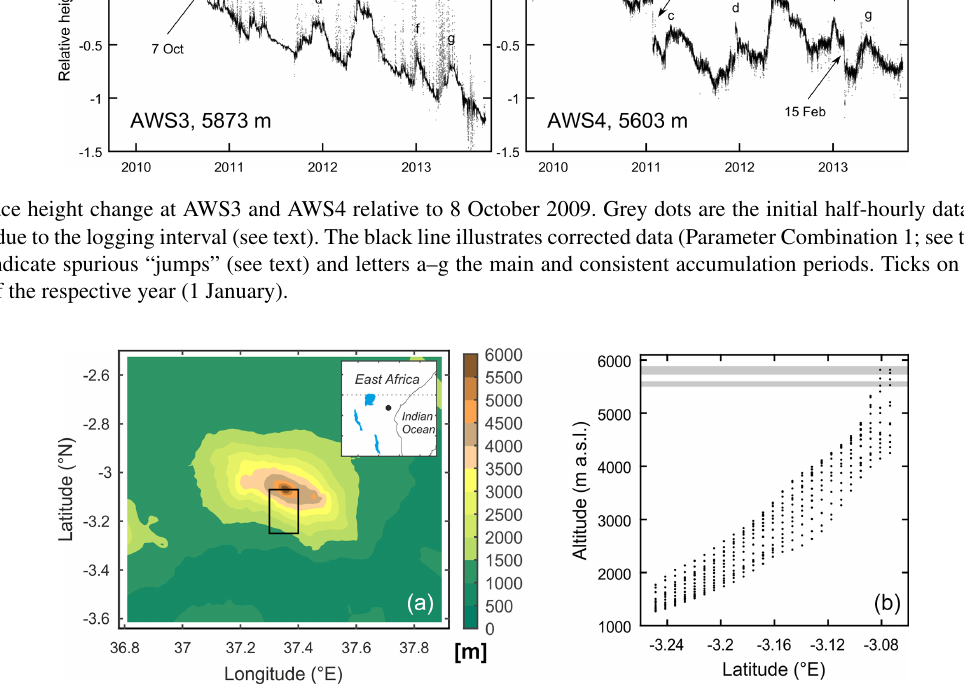
Figure 3. (a) Topography of the innermost domain in the atmospheric modeling study of Collier et al. (2018). The black box delineates the “southern mountain slope” defined in the present study. Inset in the upper-right corner illustrates the full area covered by the model’s (outermost) computational domain and the location of Kilimanjaro (dot). (b) Meridional profile of altitude on the southern slope indicated by the single grid points ( n = 350); the defined upper and lower summit zone are highlighted by grey